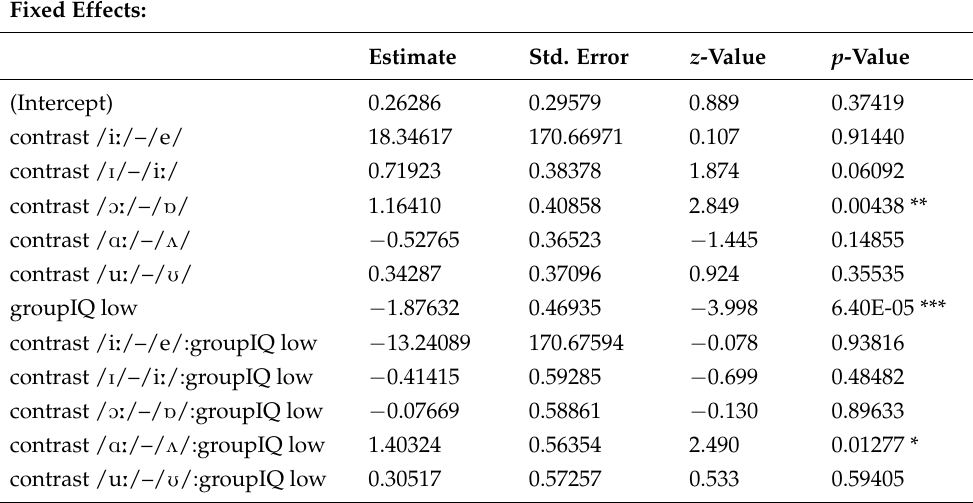
Table 1. Results of the binomial mixed-effects model (Intercept: groupIQ high, contrast /æ/–/ A: /). Fixed